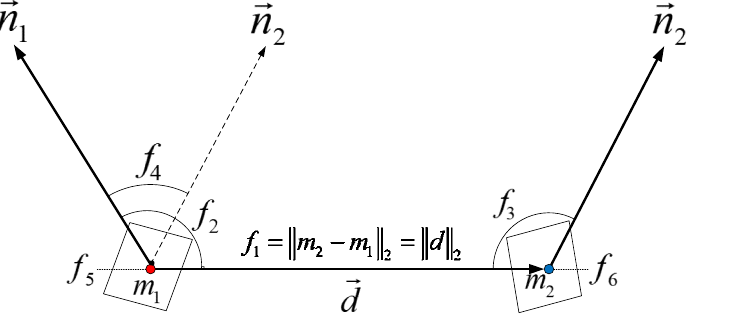
Figure 3. The model description of the Cur-PPF feature. This feature is different from the PPF because curvature information f 5 and f 6 are introduced to Cur-PPF, which strengthens the feature description.